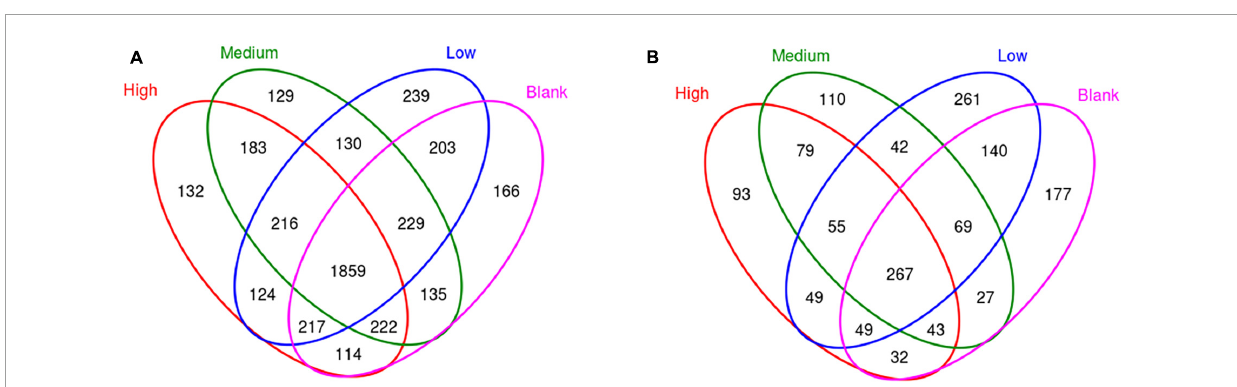
for extraction. The quality and concentration of the DNA extracted was detected by 1% agarose gel electrophoresis and spectrophotometry. The mean of DNA concentration was 212.5 ng/ µ l with standard deviation of 42.33. Samples were stored at − 20 ◦ C for subsequent